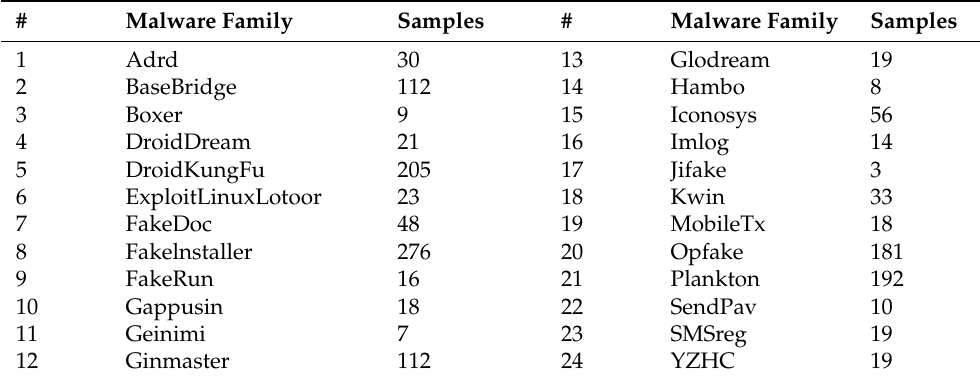
Table 3. Number of malware samples for